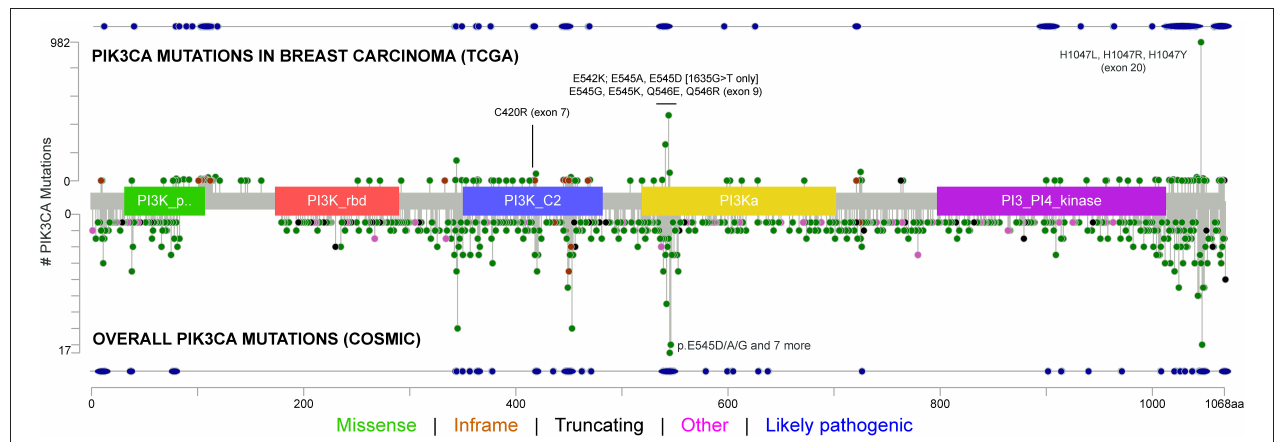
FIGURE 2 | Type of mutations, frequency, and affected PIK3CA domains across breast cancers from The Cancer Genome Atlas (TCGA) Network and selected solid tumors from the Catalog Of Somatic Mutations In Cancer (COSMIC) datasets, including the mutations and exons covered by the FDA-approved the RT-PCR test. The tumor types included in this analysis are non-small cell lung cancer (i.e., squamous cell and adenocarcinoma), esophageal cancer, stomach cancer, colorectal cancer, cholangiocarcinoma, pancreatic cancer, liver cancer, bladder cancer, prostate adenocarcinoma, uterine cancer (i.e., endometrioid, serous, and carcinosarcoma), ovarian cancer, and invasive breast cancer. The types of mutations and their likely pathogenicity are color-coded based on the legend at the bottom.